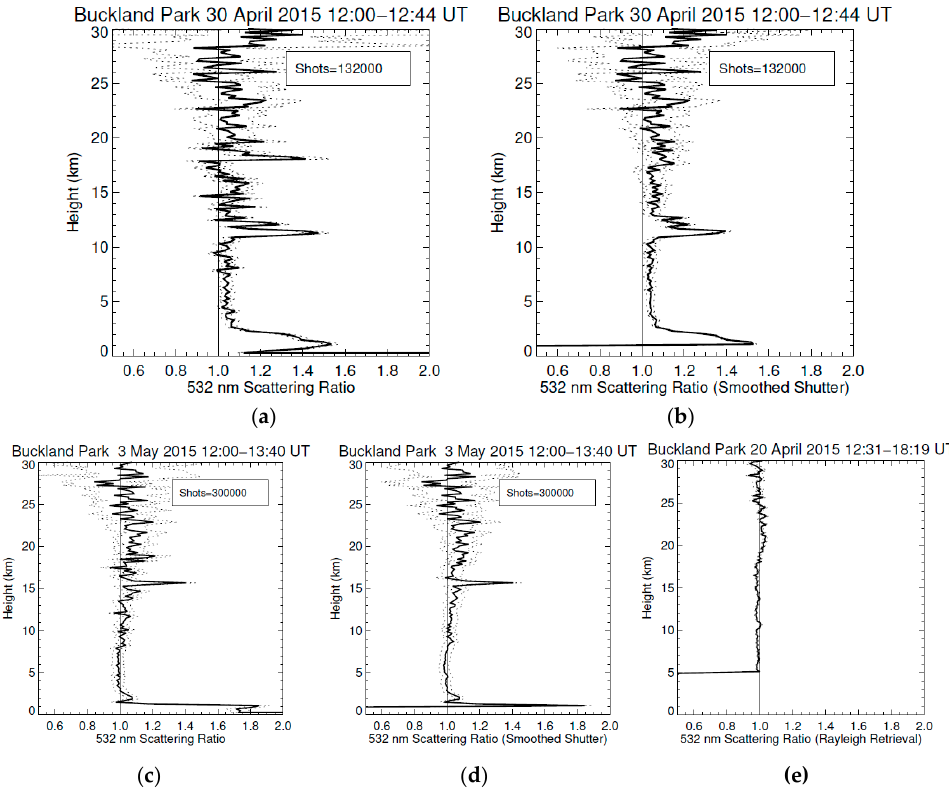
Figure 1. Retrieved 532 nm mean scattering ratio for Buckland Park lidar measurements for ( a ) and ( b ) 30 April and ( c ) and ( d ) 3 May 2015 using 200 m vertical resolution. In panels ( b ) and ( d ), the correction for the transmission of the rotating shutter has been smoothed with a polynomial fit as discussed in Section 3.1. The solid vertical line marks unit scattering ratio. Thin dashed lines mark 1 σ (1 standard deviation) significance limits. ( e ) Scatting ratio for measurements on 20 April 2015 before the Calbuco eruption. The vertical resolution is 200 m. The profile from 5 to 20 km has been adjusted for height-dependent attenuation the geometric overlap function discussed in Section 3.1.